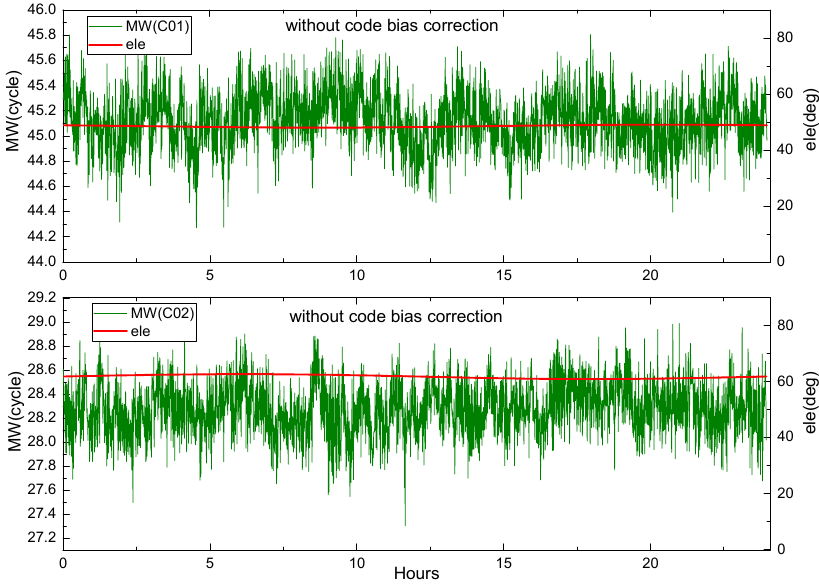
Figure 3. The M-W variation of C01, C02 at XMIS, on DOY 083, 2018.